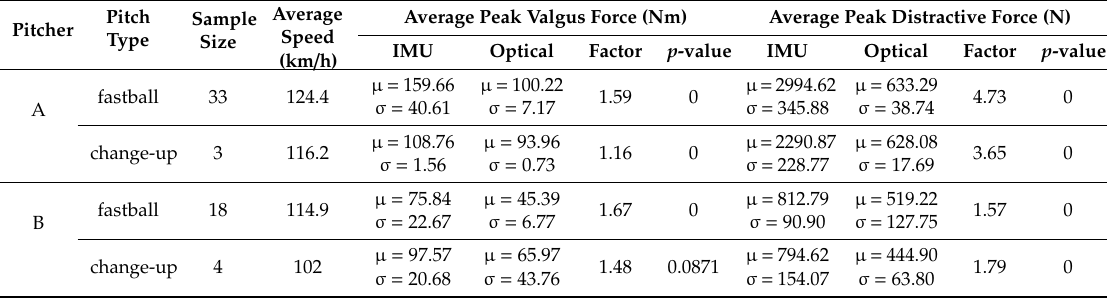
Table 1. Descriptive findings for elbow valgus torque and shoulder distractive force as derived from inertial and optical systems across the two